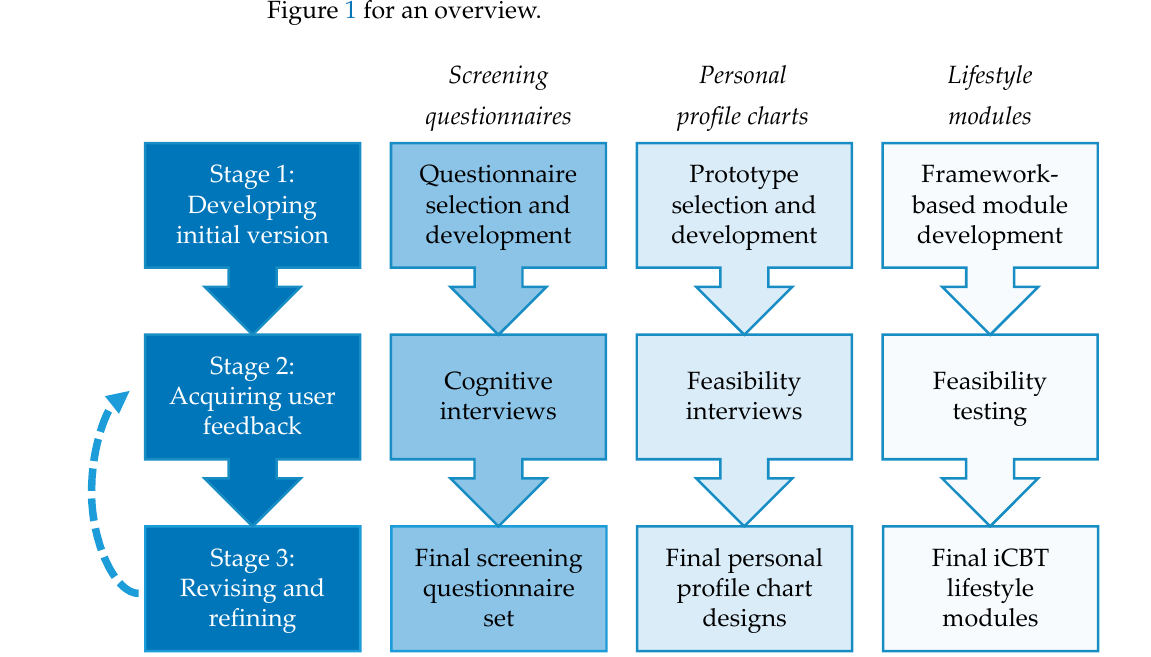
Figure 1. Stages of intervention development per intervention component. iCBT = Internet ‐ delivered cognitive ‐ behavioral therapy.